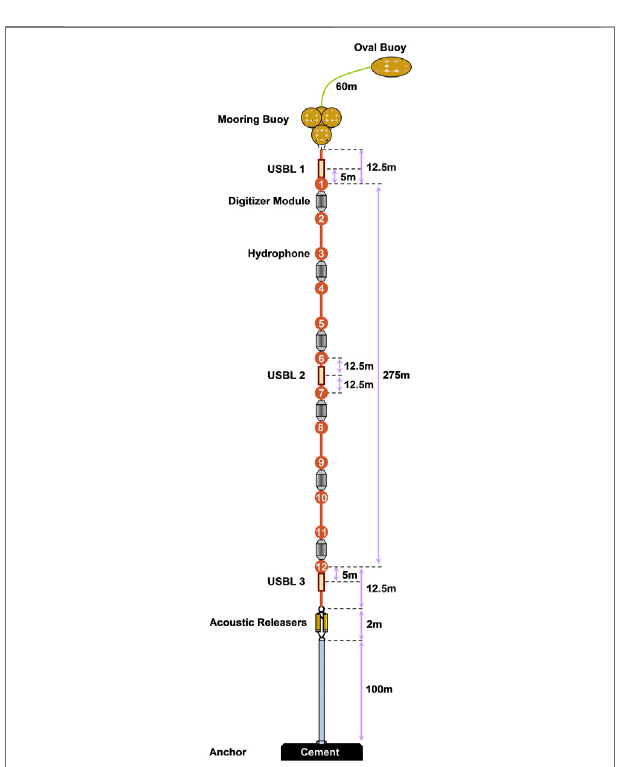
FIGURE 2 | Distributed vertical cable seismic acquisition